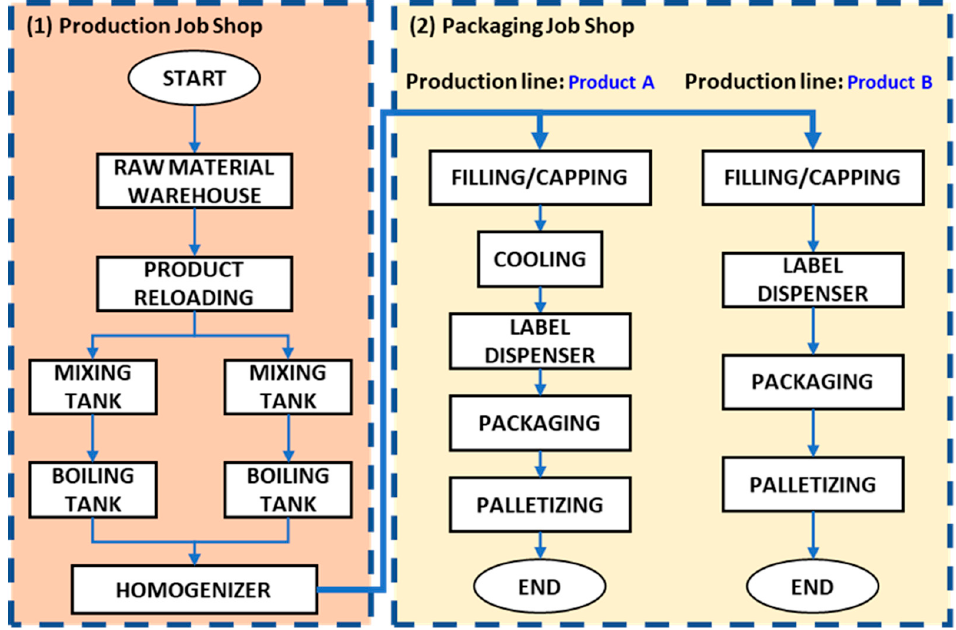
Figure 8. Flowchart of the Process Industry Production Line Under Investigation.